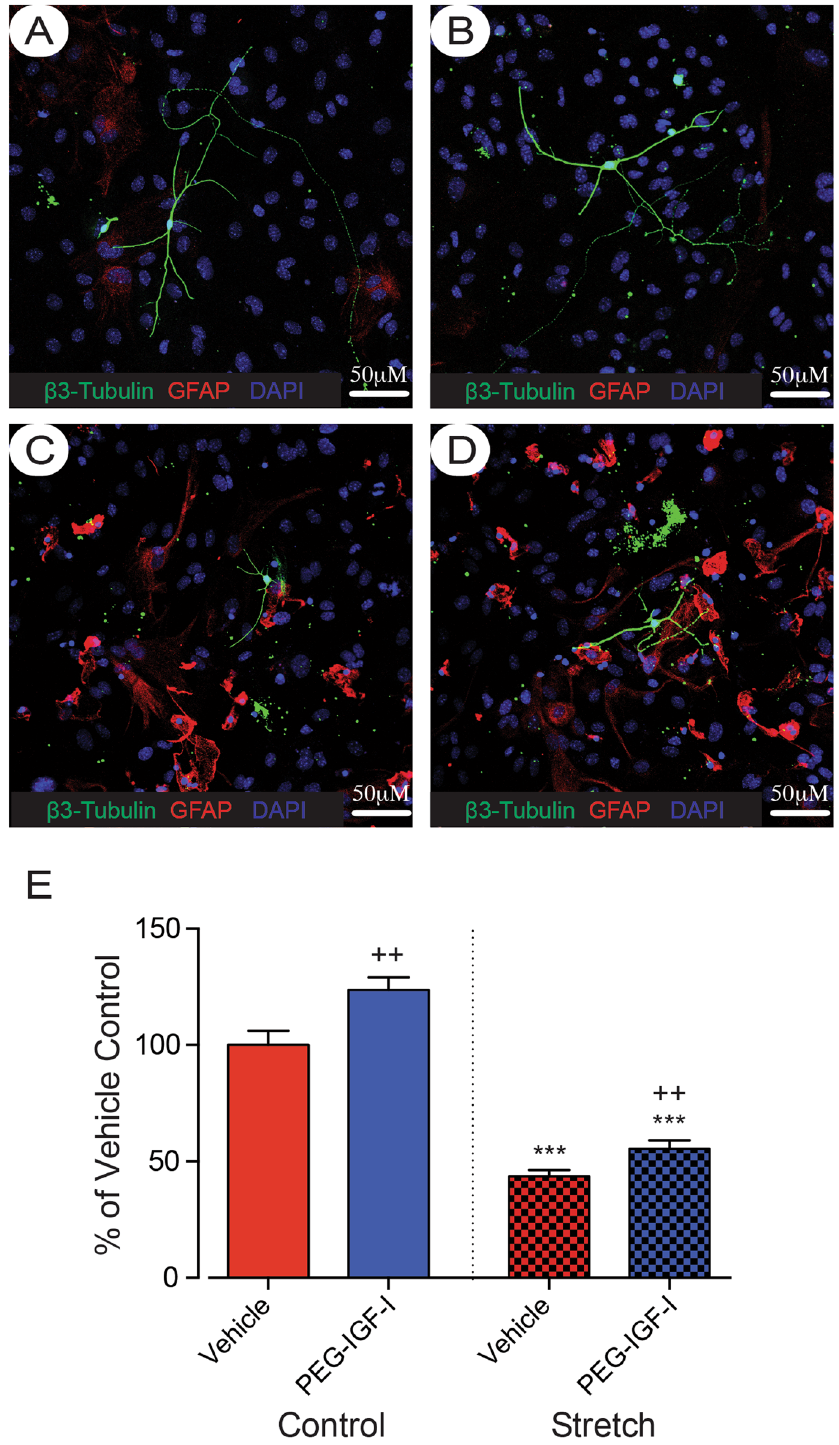
Figure 7. PEG-IGF-I increases neurite outgrowth of cortical neurons plated on top of stretched astrocytes. Representative images of individual neurons are shown for control + vehicle ( A ), control + 100 ng/mL PEG- IGF-I ( B ), stretch + vehicle ( C ), and stretch + 100 ng/mL PEG-IGF-I ( D ), scale bar represents 50 μ m. Reactive astrocytes are shown in red (GFAP), neurons in green ( β 3 tubulin) and the nuclear counter label in blue. Quantification of total neurite lengths ( E ) reveals that 24 hrs treatment with 100 ng/mL PEG-IGF-I increases neurite outgrowth of neurons plated on top of stretched astrocytes but not control astrocytes. Data is expressed as mean ± SEM from 3 independent co-cultures, each performed in triplicate (45 neurons per condition were analysed). *** P < 0.001 compared with vehicle-treated non-stretched controls; ++ P < 0.001 compared with vehicle-treated stretch and non-stretch